Question: What form of chart is displayed?
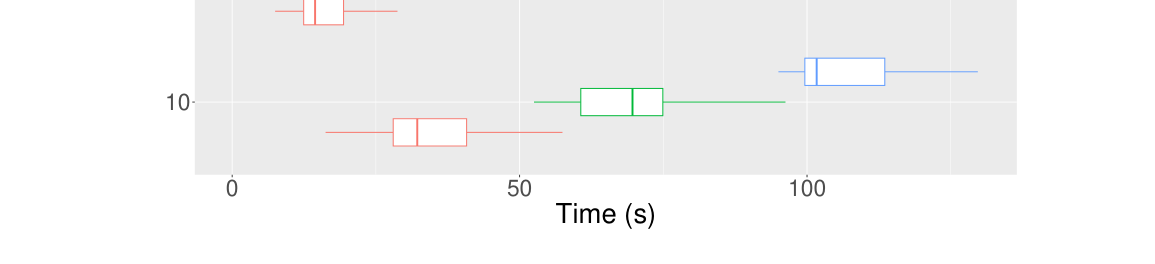
Answer: box